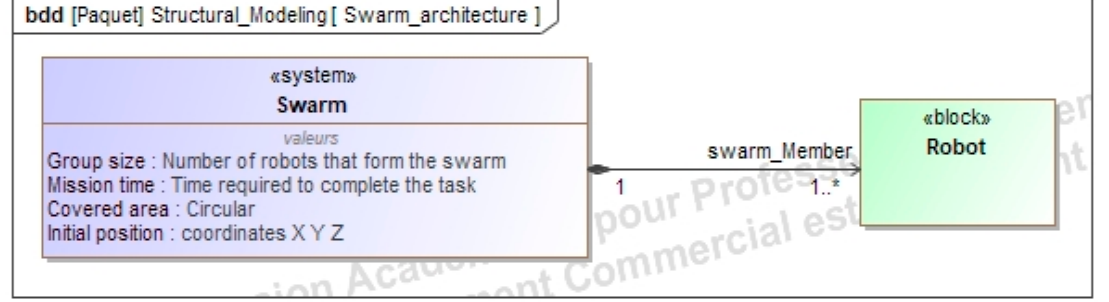
Figure 5. General architecture of the swarm in SysML.